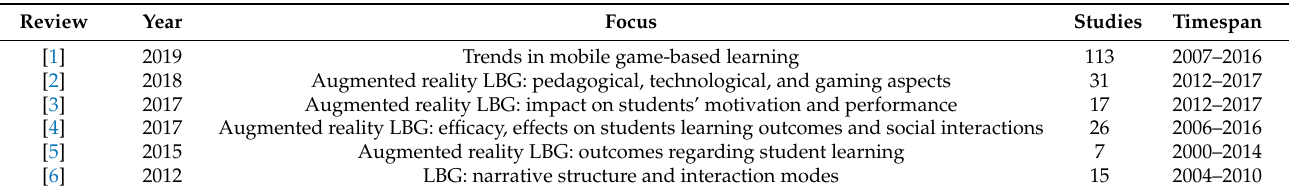
Table 1. Studies reviewing location-based games for